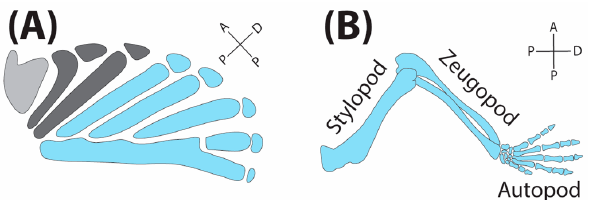
Figure 1. Representative fin and limb endoskeletal anatomy. ( A ) Pectoral fin endoskeleton of a non-teleost actinopterygian, the paddlefish Polyodon spathula , with fin rays removed for clarity. ( B ) Forelimb endoskeleton of a tetrapod, the mouse Mus musculus , highlighting proximo-distal regionalization of the appendage. Propterygium (light gray), mesopterygium (dark gray), and metapterygium (blue). Illustrations not to scale.